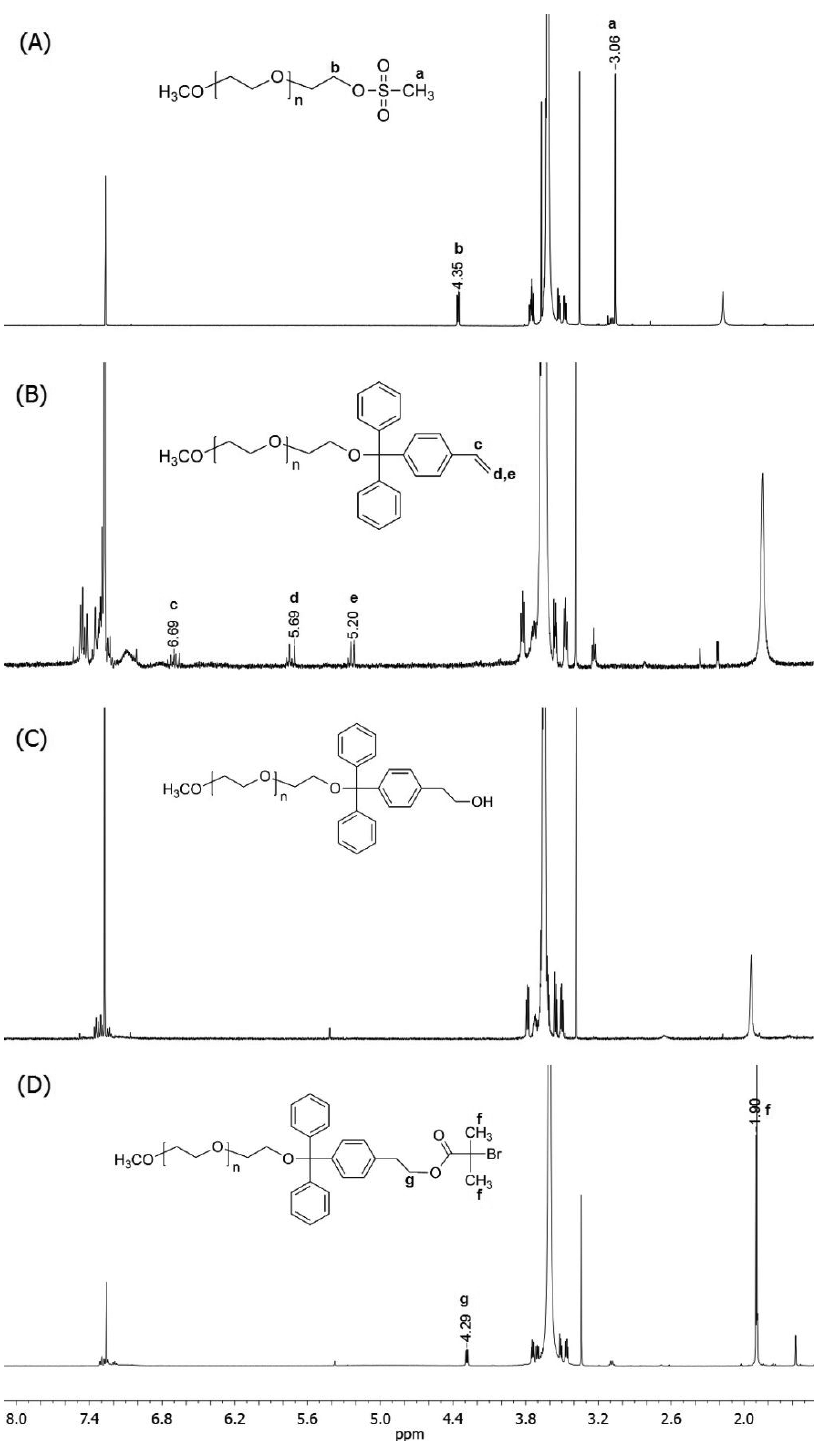
Figure 1: 1 H NMR spectra of the synthesis of ATRP macroinitiator: (a) MPEG-mesylate, (b) PEG-VinylTTE, (c) PEG-HydroxyTTE, (d)